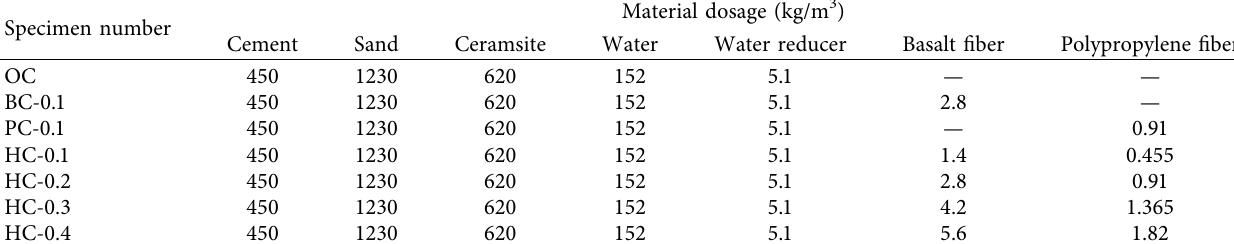
Table 3: Mix proportion of HFLAC.